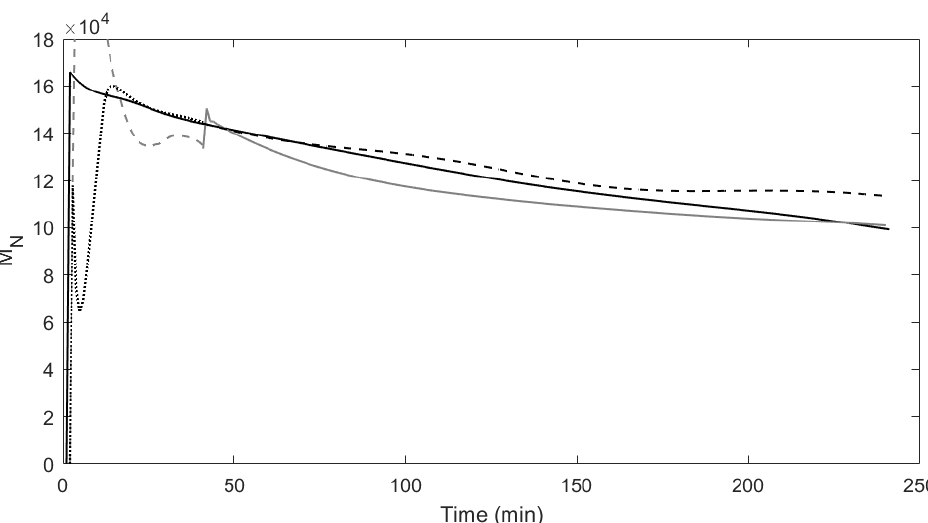
Figure 5. The number average molecular weight predictions from both models with every tenth quality measurement retained and 20% missing output data. The dashed grey lines represent estimates made by the Luenberger observer until the 40th minute and the solid grey line shows the predictions from the proposed approach in comparison to the process, represented by the solid black line. The dotted and dashed black lines show the estimates made by the Luenberger observer and traditional subspace identification using linear interpolation,